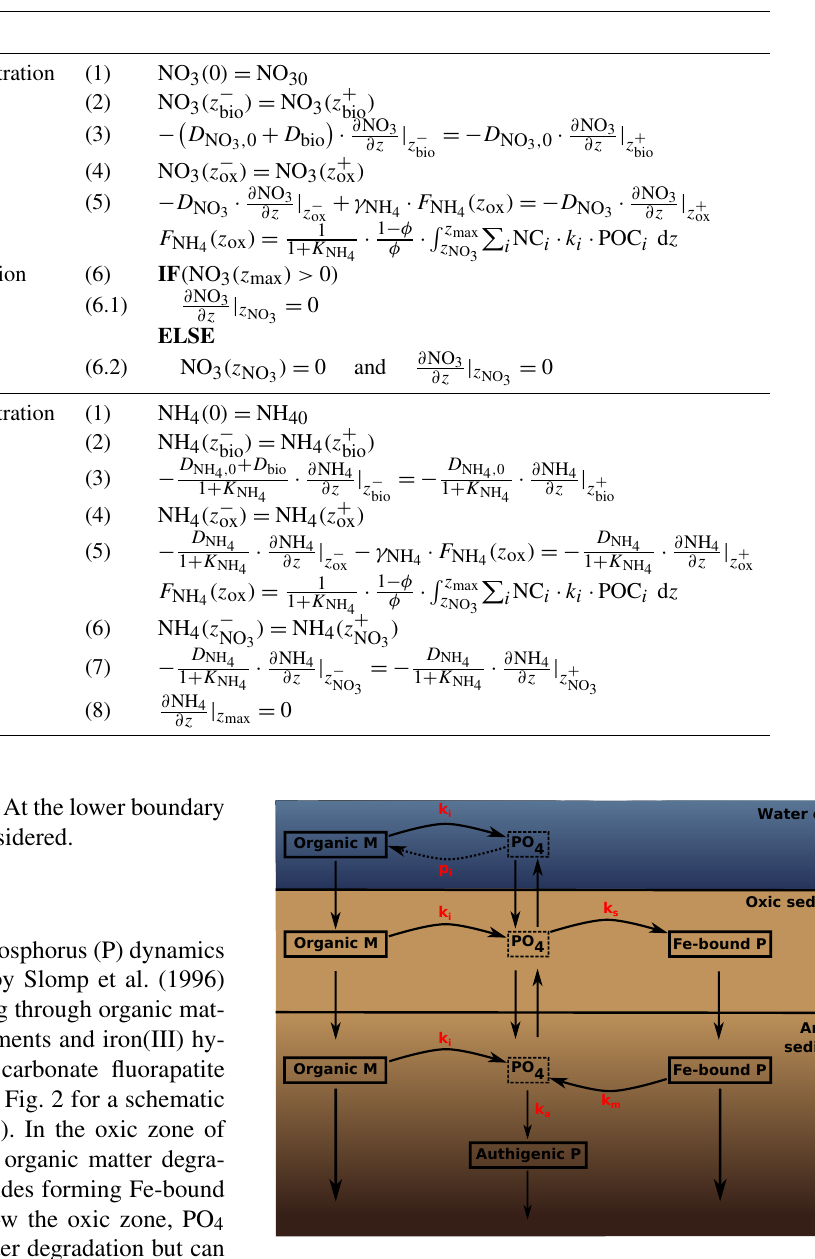
Figure 2. A schematic of the sedimentary P cycle in OMEN-SED. Red numbers represent kinetic rate constants for phosphorus dy- namics (compare to Table 10; p i represents the uptake rate of PO 4 via primary production in shallow environments). Adapted from Slomp et al.